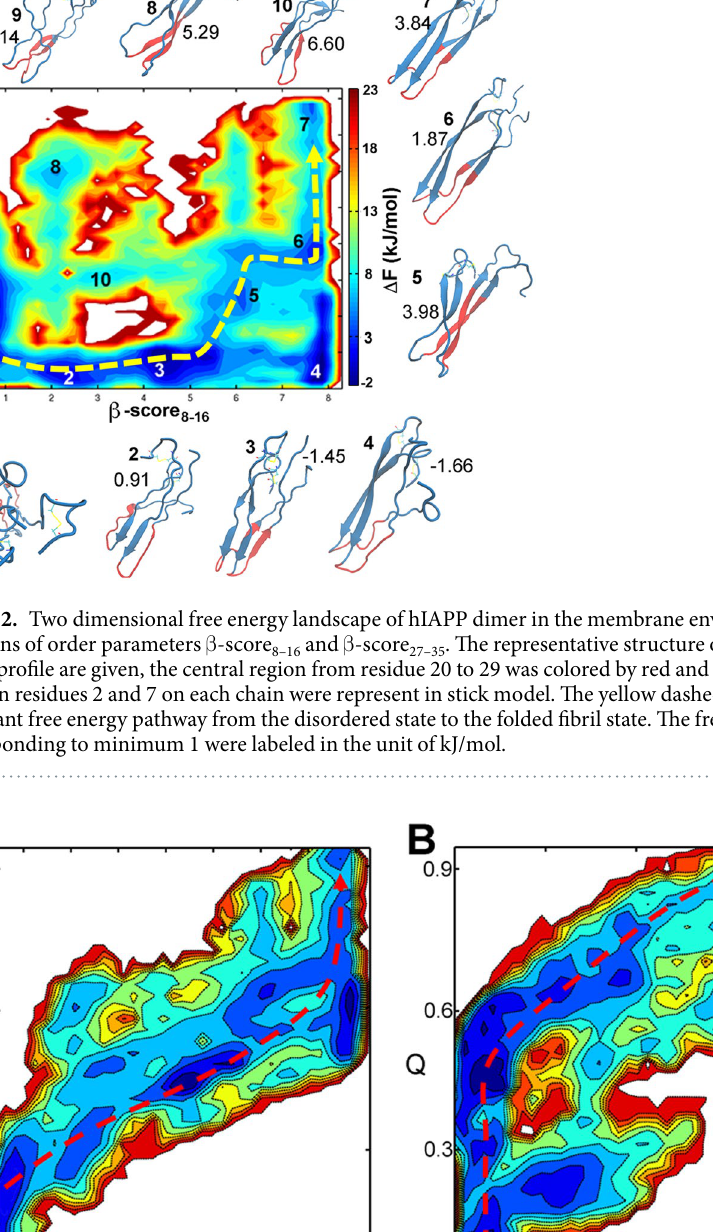
structures were formed firstly. On the contrary, the C-terminal β -sheet structures were formed at first in the other pathway. However, in the membrane environment there is a dominant fibril-like structure formation pathway (The yellow dashed line in Fig. 2). To further analyze the contributions of N- or C- terminal sheets to the fibril formation, we plot the free energy landscapes as function of β -scores and Q 8–16 , 27–35 parameters (Fig. 3). It can be seen that the growth of N-terminal β -sheet is basically synchronous with the increasing of Q 8–16,27–35 before the value 0.5 (Fig. 3A), and after the fully formation of N-terminal β -sheets, the Q value keep going up to 1. However, the Q increased to about 0.5 with the β -score 27–35 close to 0, and after that, the β -scores on the C-terminal region